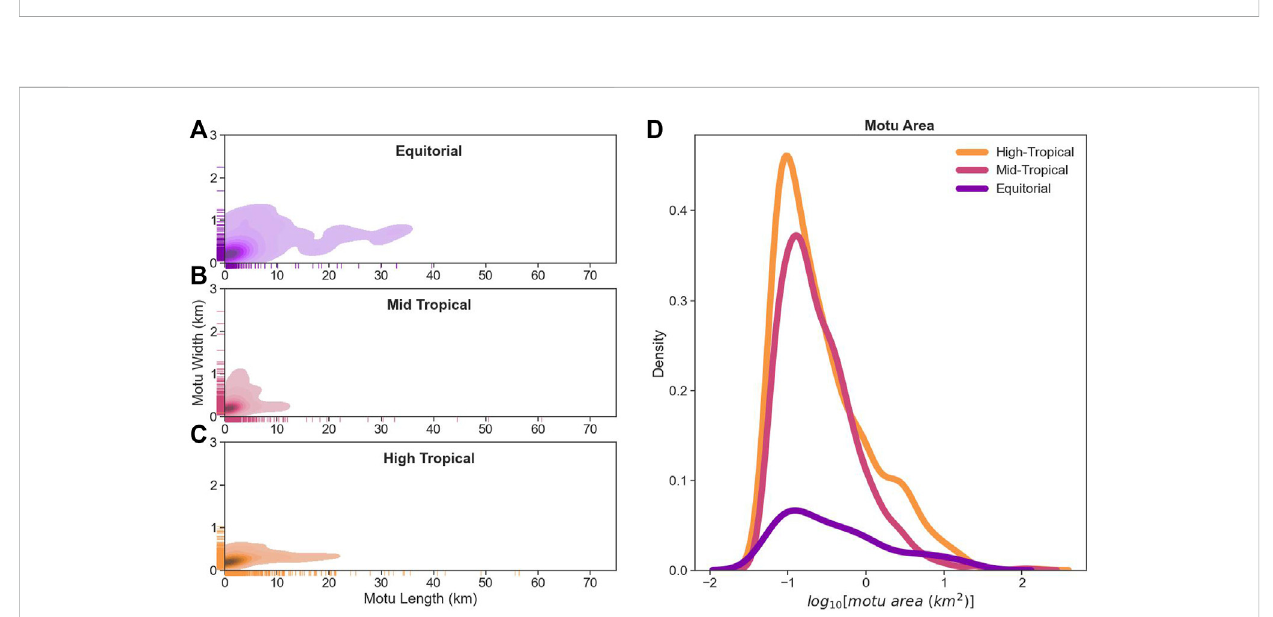
FIGURE 10 Densityfunctionof (D) log 10 (motuarea)forallatollsonaper-motubasisgroupedbylatitude,with2Ddistributionofmotulengthandmotuwidthfor (A) equatorial (purple), (B) mid tropical (pink), and (C) high tropical motu